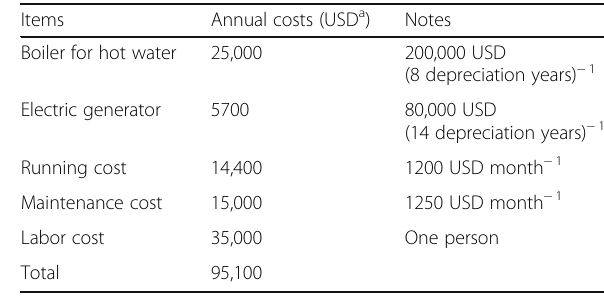
Table 3 Cost of the boiler in Route